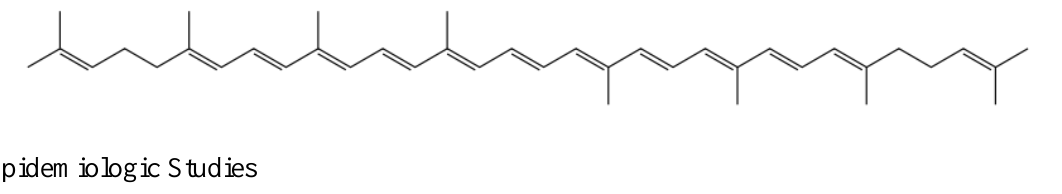
Figure 4. Chemical structure of